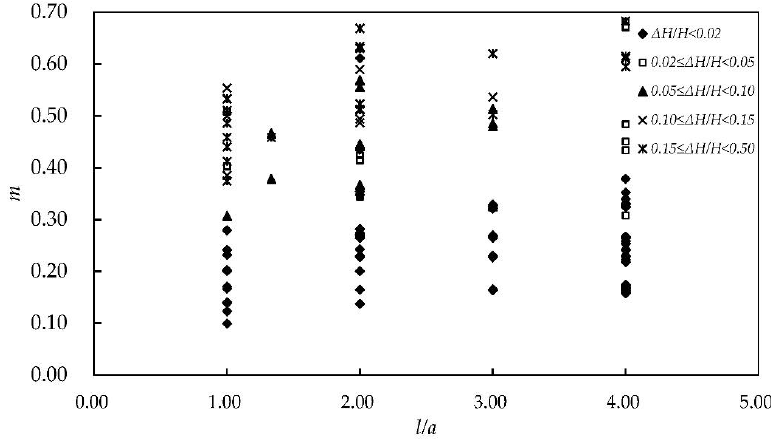
Figure 5. The plot of m versus e /Δ H for l / a values.